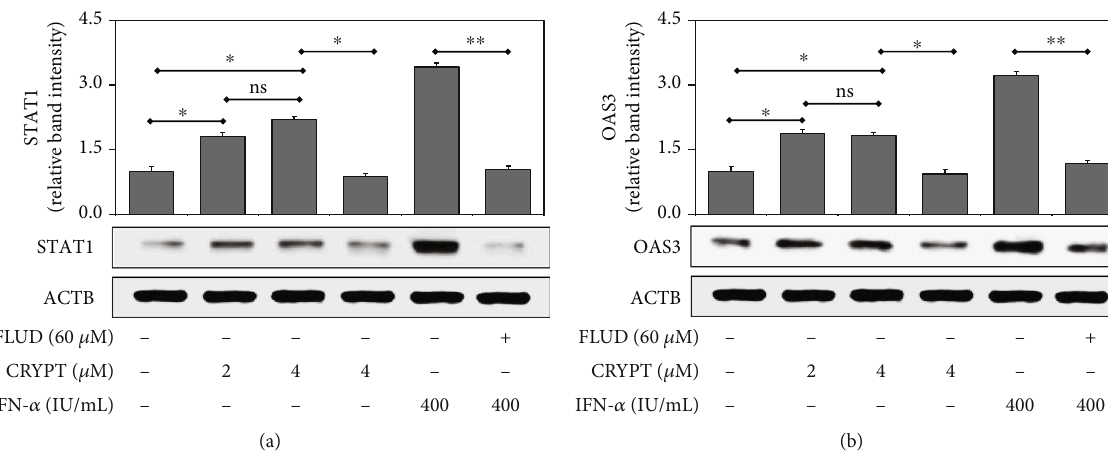
Figure 3: Cryptolepine increases STAT1 and OAS3 protein levels in THP1-derived macrophages. The derived macrophages were cotreated with fl udarabine (FLUD) and cryptolepine (CRYPT) or IFN- α . The target proteins were assessed after 24h by western blotting using the indicated antibodies. β -Actin (ACTB) was included as a protein loading control. The images are representative of three varied experiments. ∗ p < 0 : 05 and ∗∗ p < 0 : 01 ; ns: di ff erence not signi fi cant (one-way ANOVA and Bonferroni ’ s test).